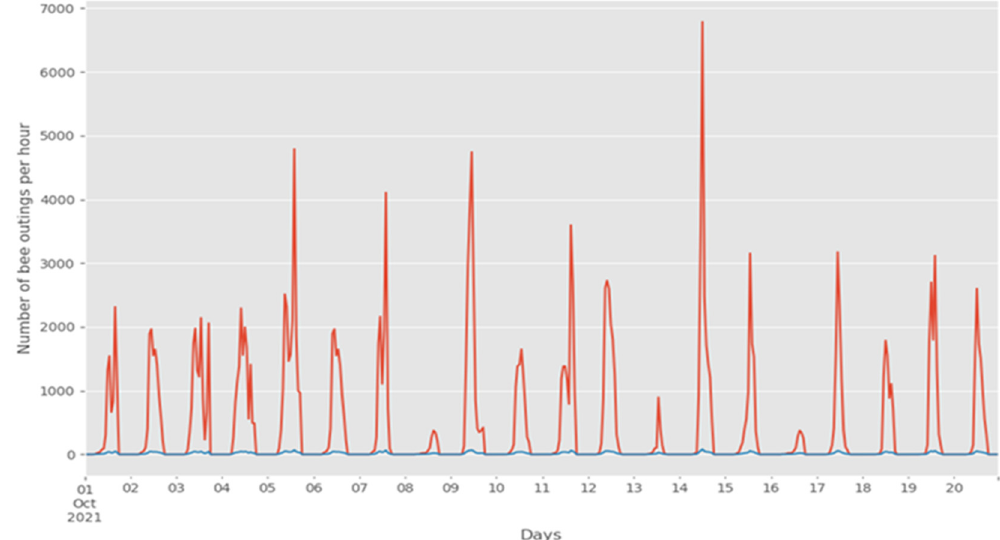
Figure 7. Number of bees counted per hour for 20 days.